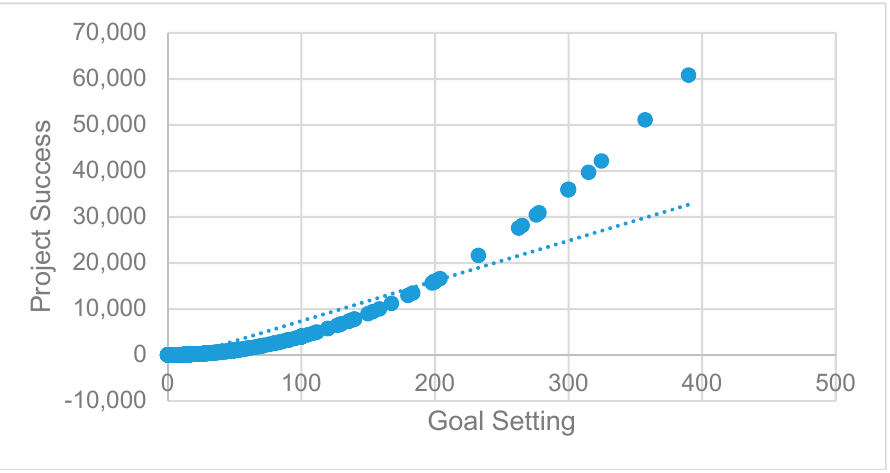
Figure 2. The non-linear effect of goal setting on project success.